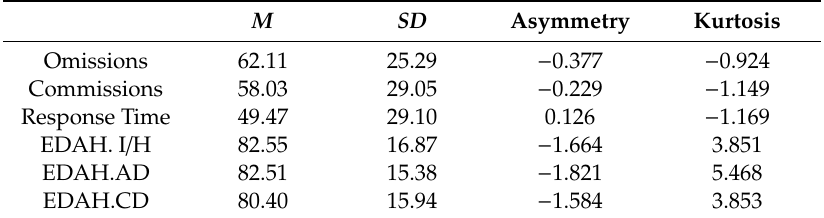
Table 1. Descriptive Statistics for VR-CPT variables and EDAH